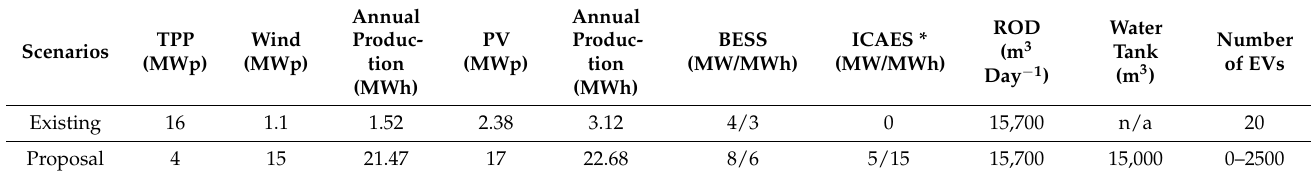
Table 3. Existing and proposed energy system assets in Porto Santo.